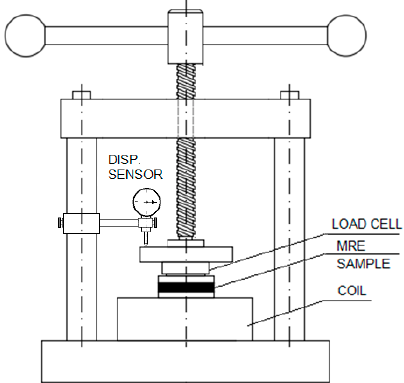
Figure 7. Scheme of the test rig used for axial characterization.